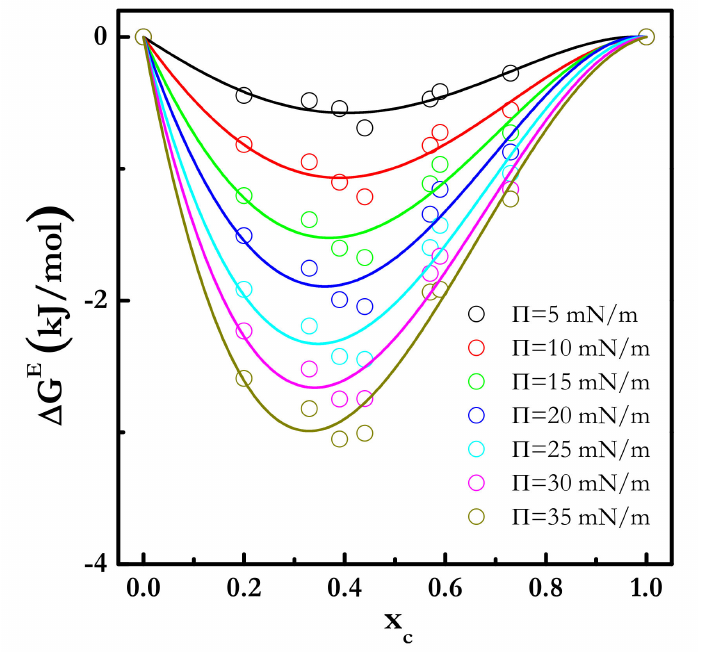
Figure 4. Dependences of the excess free energy of mixing on x CH for binary mixtures of CH and CS spread at the water/vapor interface at different surface pressures at 24 ◦ C. The lines represent the fitting of the experimental data to a Redlich–Kister type Equation (Equation